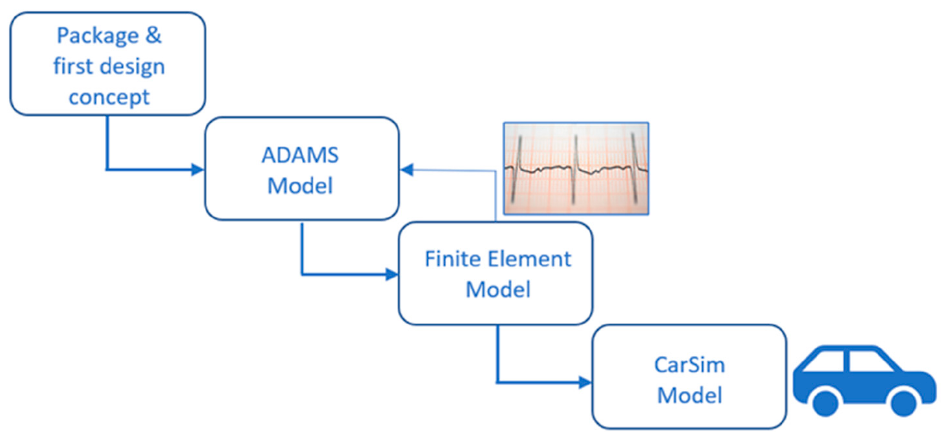
Figure 8. Detailed electric retrofit analysis process as proposed in a study, redrawn from [88].